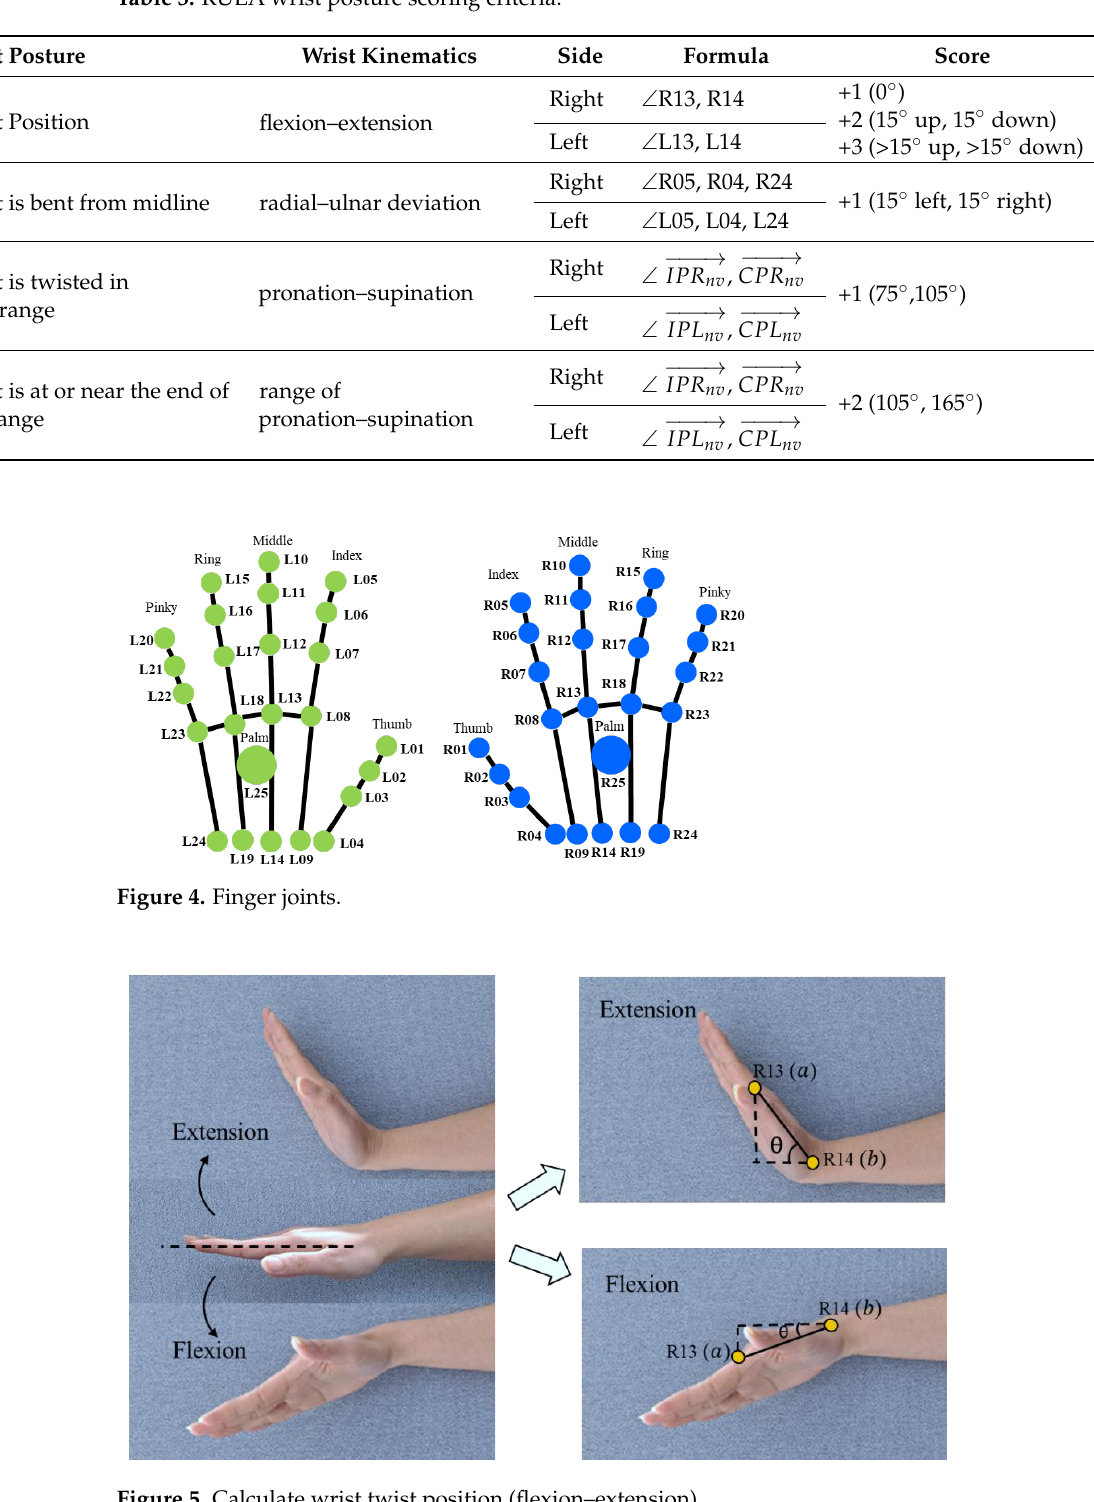
Figure 5. Calculate wrist twist position (flexion –